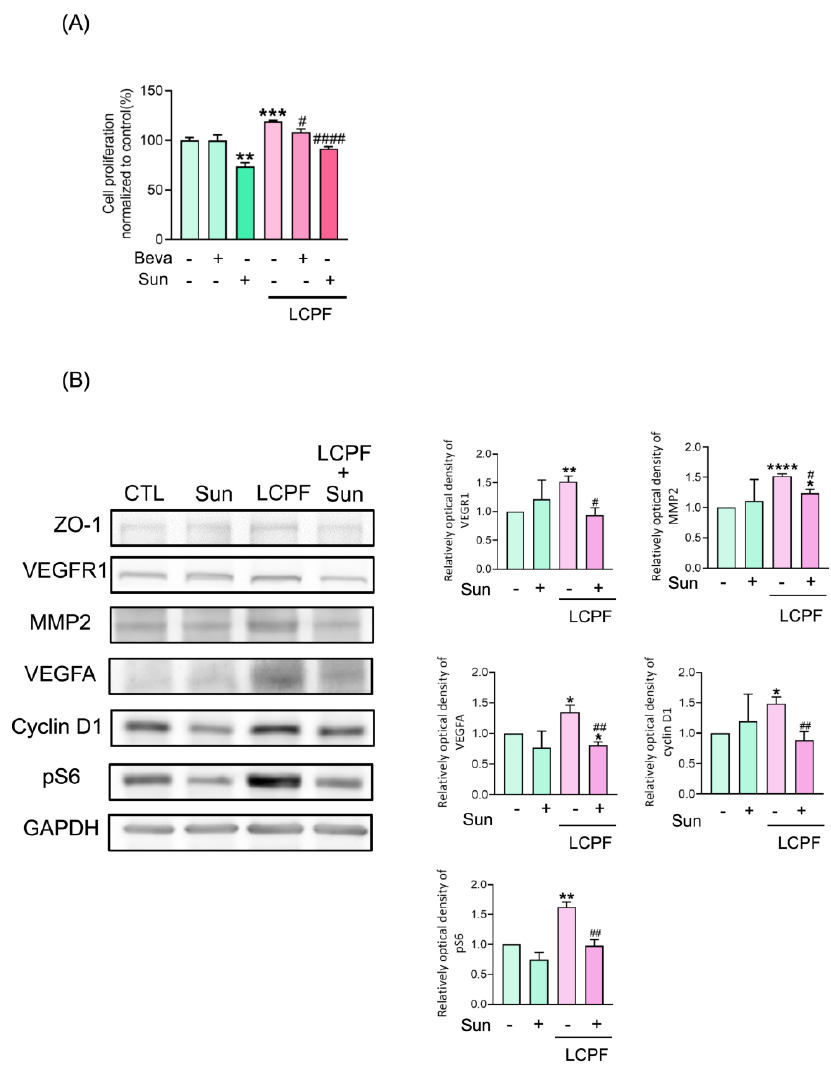
Figure 6. Reverse effect of VEGFR2 inhibitor on keratinocyte cell viability, MMP2, cyclin D1, and pS6 upregulated by LCPF. HaCaT cells were treated with or without 10 µM of sunitinib (Sun), applied as a VEGFR2 inhibitor, in the presence of LCPF for 24 h. ( A ) Cell viability was assessed using an MTT assay. ( B ) MMP2, VEGFA, p21, and pS6 protein expression was examined via Western blot analysis. * p < 0.05; ** p < 0.01; *** p < 0.005; **** p < 0.0001 compared to the control group. # p < 0.05; ## p < 0.01; #### p < 0.0001 compared to the corresponding LCPF group.